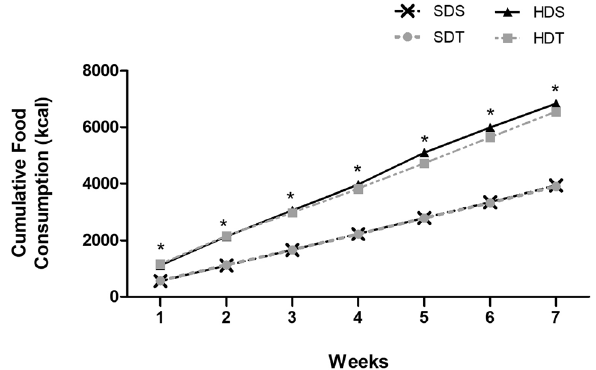
Figure 2. Assessment of cumulative food consumption. Data expressed as mean ± SEM, (n = 10/group). SDS standard diet plus sham tDCS treatment, SDT standard diet plus tDCS treatment, HDS hypercaloric diet plus sham tDCS treatment, HDT hypercaloric diet plus tDCS treatment. *Significant difference between SDS and SDT groups and HDS and HDT groups (GEE, p <